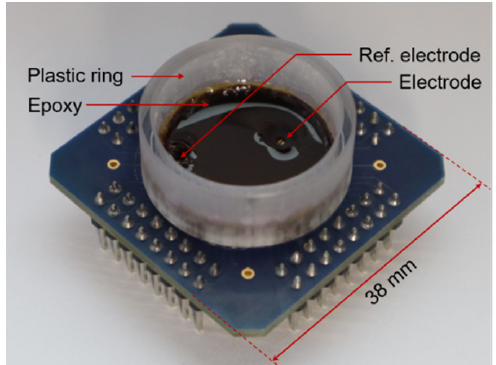
Figure 10. Chip and package used for in vitro validation. The plastic ring defines the well by which cells and cell culture medium are confined during recordings. The bottom of the well is mainly covered with epoxy, with the exception of the electrode area. The chip was cleaned and sterilized, and the electrodes were coated with human fibronectin to facilitate cell attachment. Human induced pluripotent stem cells (hIPSCs) derived from a healthy donor were purchased from FUJIFILM Cellular Dynamics Inc. The human induced pluripotent stem cell (hIPSC) line, CW30318CC1, was obtained from the CIRM hPSC Repository funded by the California Institute of Regenerative Medicine (CIRM). The hIPSCs were then differentiated into spontaneously and synchronously beat- ing cardiomyocytes. The cardiomyocytes were carefully lifted from the cell culture dish to not disrupt the cell-cell connections. The cardiomyocyte tissue was then transferred and allowed to adhere to the surface with the coated electrodes. Figure 11 shows an electrical recording taken inside an incubator one hour after transferring the tissue to the chip. The input capacitor was set to C 0 = 4.25 pF, and the output bitstream was band-pass filtered with a fourth-order Butterworth band-pass filter between 5 Hz and 200 Hz. Cardiac action potentials with an amplitude of approximately 100 µ V pp and a beating rate of 95 beats per minute are visible. This beating rate matches the rate measured by observing the contractions of the tissue through the